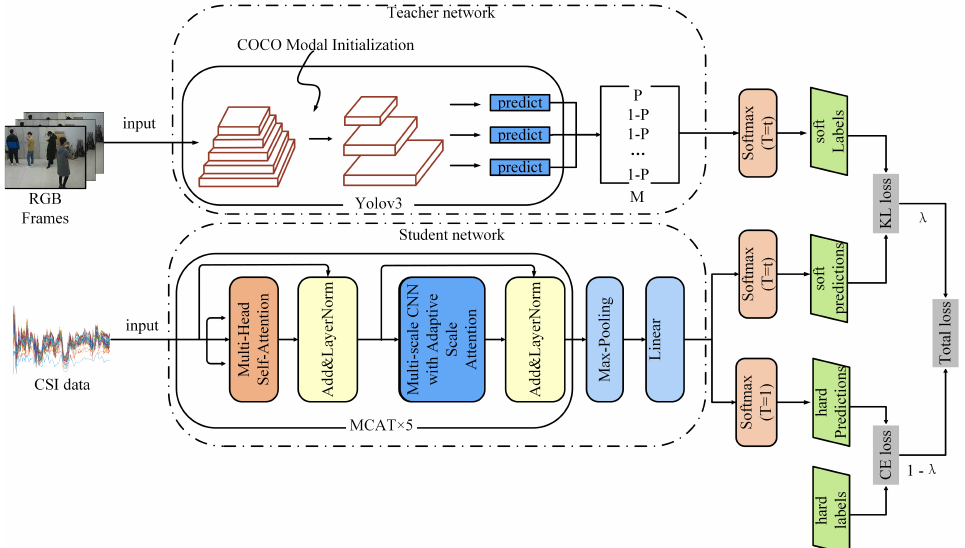
Figure 1. The training framework of CM-NET. It has two components: the teacher’s training network and the student’s training network. The teacher is a vision-based people counting network, whose network is first initialized using the trained weights from the COCO dataset and then fine-tuned with our collected video data. The student is a CSI-based people counting network, whose network training process is supervised by the soft labels from the teacher